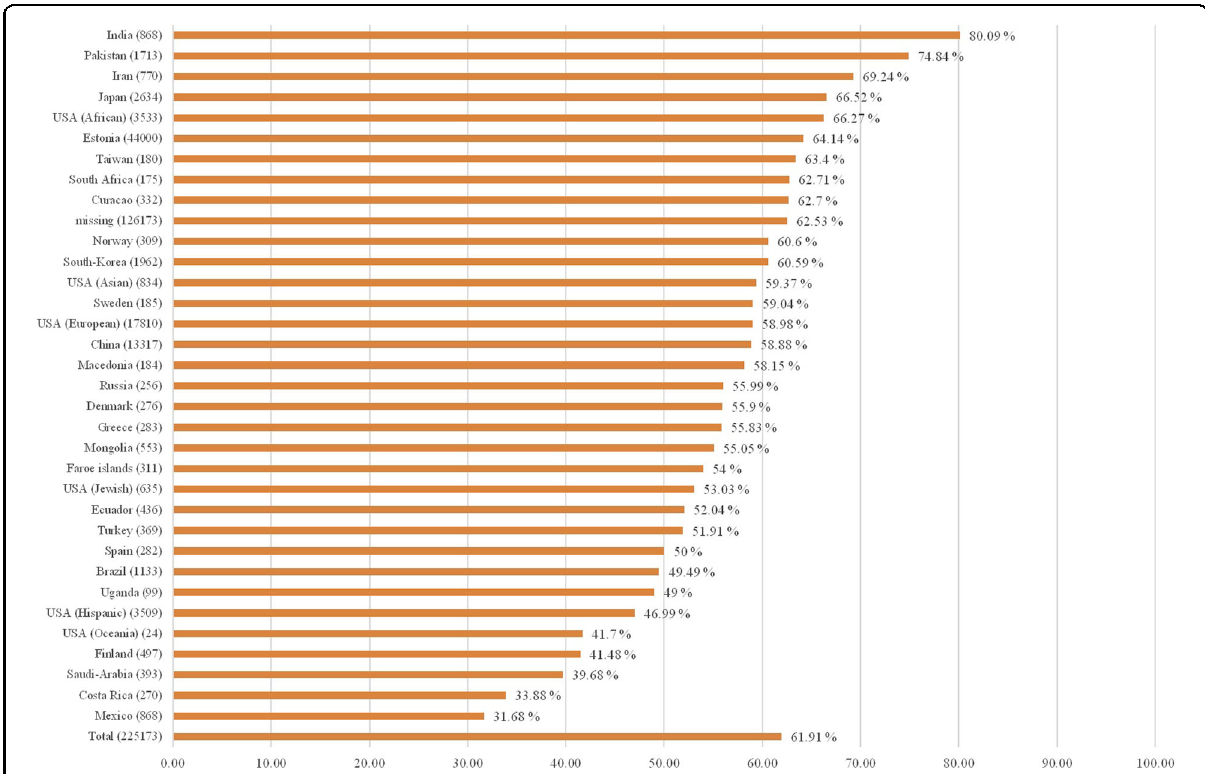
Fig. 4 CYP2C19 non-normal probability estimates per country. Country (genotyped subjects); non-normal probability estimate in